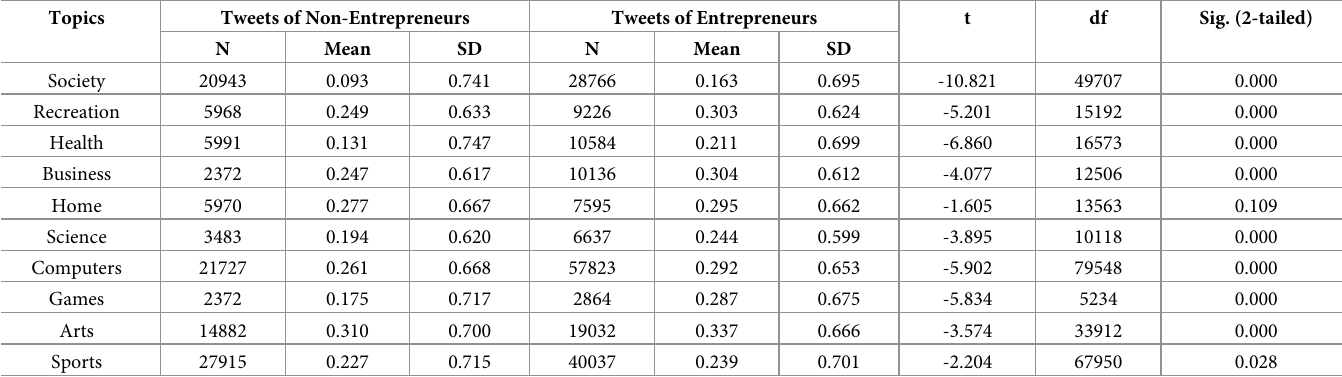
Table 9. Two-sample t-test to compare the mean emotional score per topic between entrepreneurs and non-entrepreneurs (worldwide data). Topics